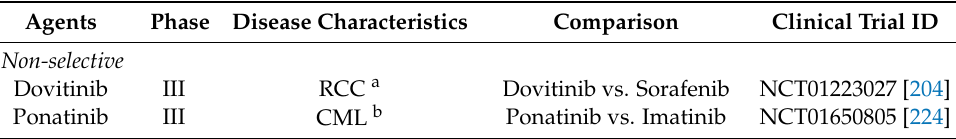
Table 6. Published phase III studies of FGF(R)